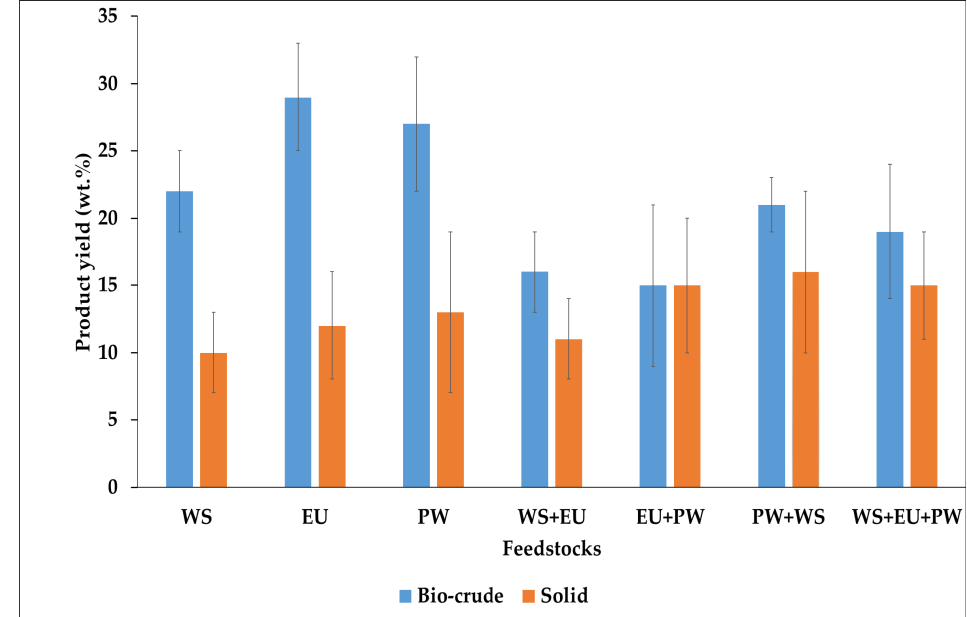
Figure 2. HTL product yield with different feedstocks.